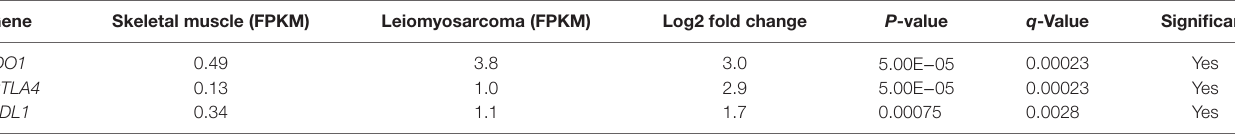
Gene expression was determined by RNA-Seq analysis with comparison of normal skeletal muscle tissue and AdCre-induced leiomyosarcoma. Expression values are given as fragments per kilobase of transcript per million mapped reads (FPKM). q-Value < 0.05 is considered significant. CTLA4, cytotoxic T-lymphocyte-associated protein 4; IDO1, indoleamine 2,3-dioxygenase 1; PDL1, programmed death-ligand 1.